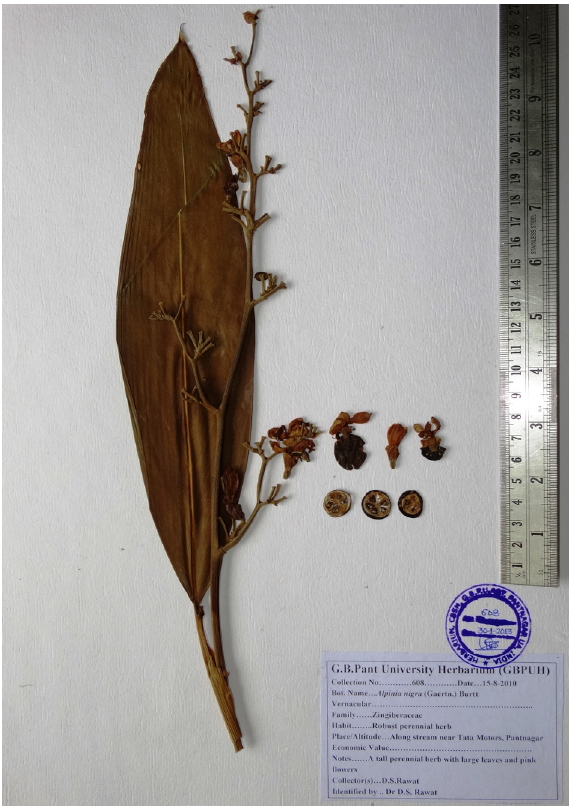
Image 13. Herbarium specimen of Alpinia nigra (Gaertn.) Burtt